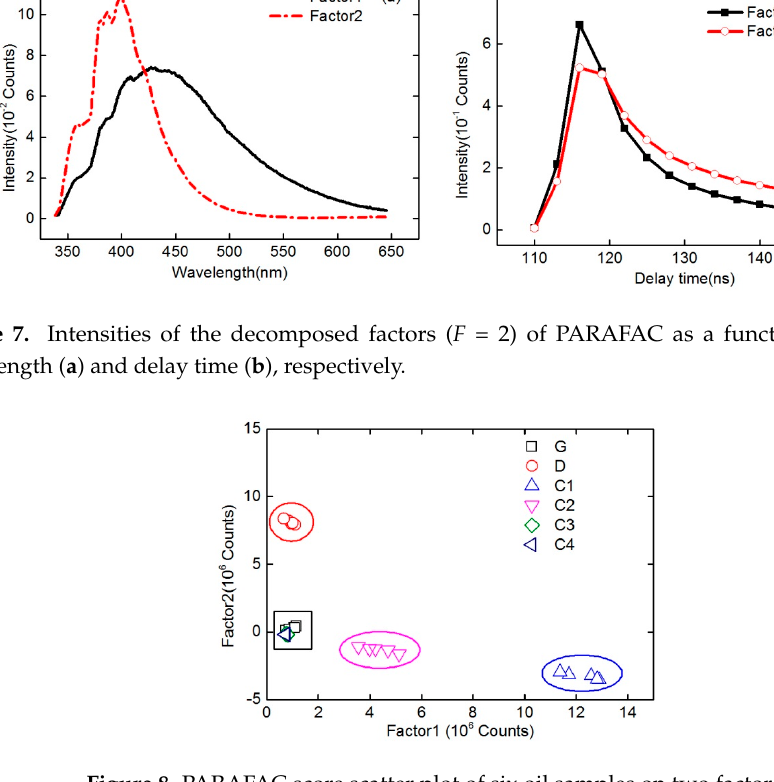
Figure 8. PARAFAC score scatter plot of six oil samples on two factors.